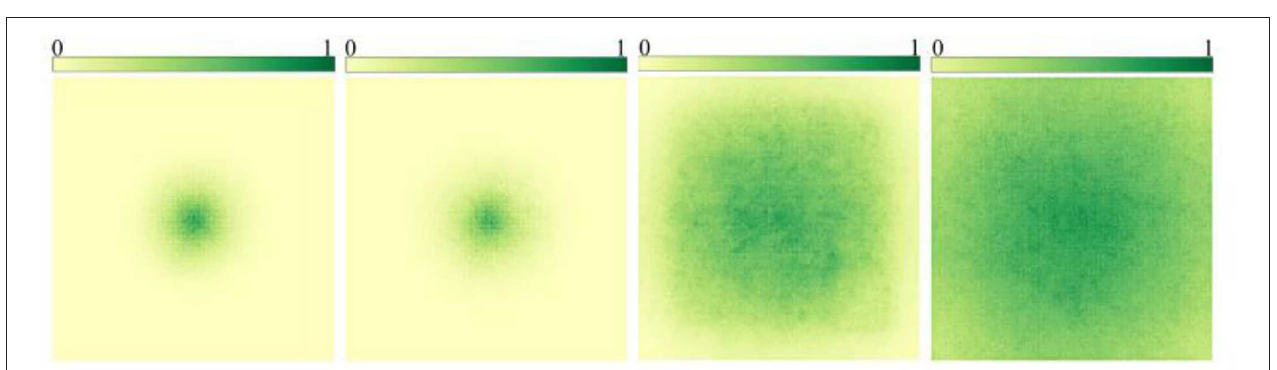
FIGURE 3 | The change of receptive field caused by the change of convolution kernel size: these images are the results of a study by RepLKNet. The first two pictures are compared and superimposed with multiple small convolution checks for the improvement of receptive field, which shows that there is not much effect. The last two pictures are the effect caused by increasing the size of the convolution kernel, which can be seen as significant.